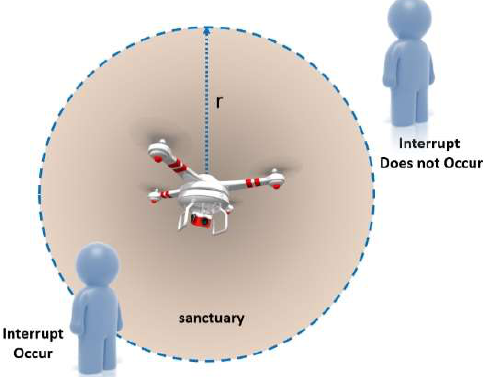
Figure 10. Monitoring of the dynamic objects.